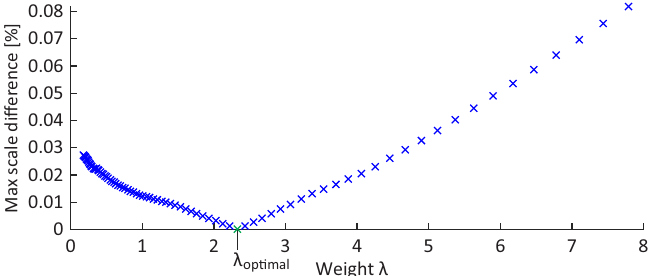
Figure 15. Maximum expected scale difference compared to the results obtained using the optimal weight λ (shown over a smaller range of weights for